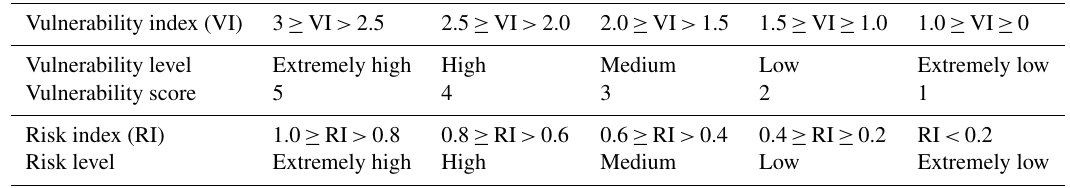
Table 11. Vulnerability and risk index, level, and score.